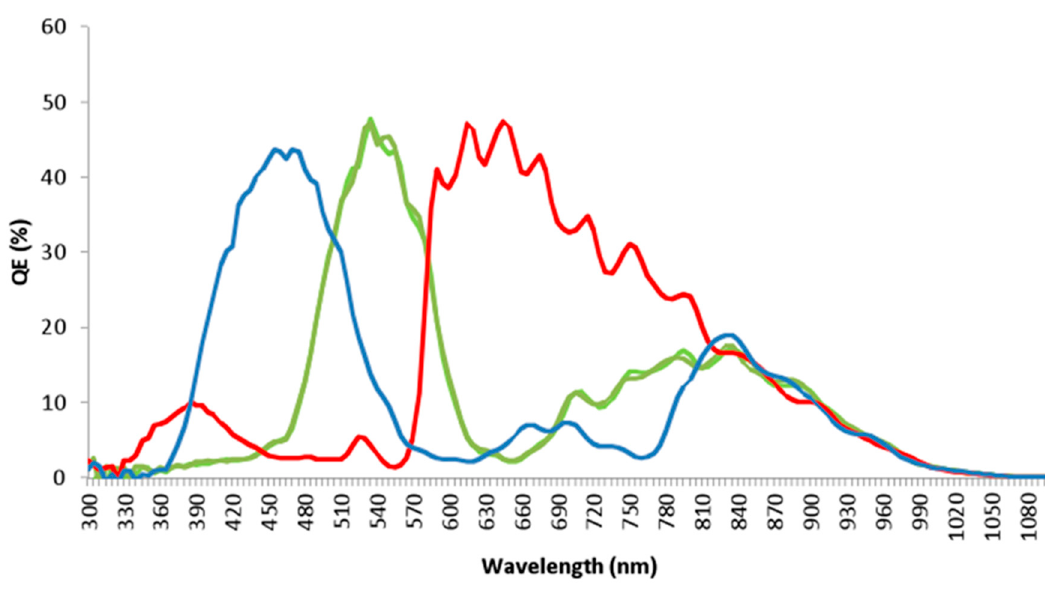
Figure 2. Spectral responses curves for the nSight-1 (image credit: SCSAG).